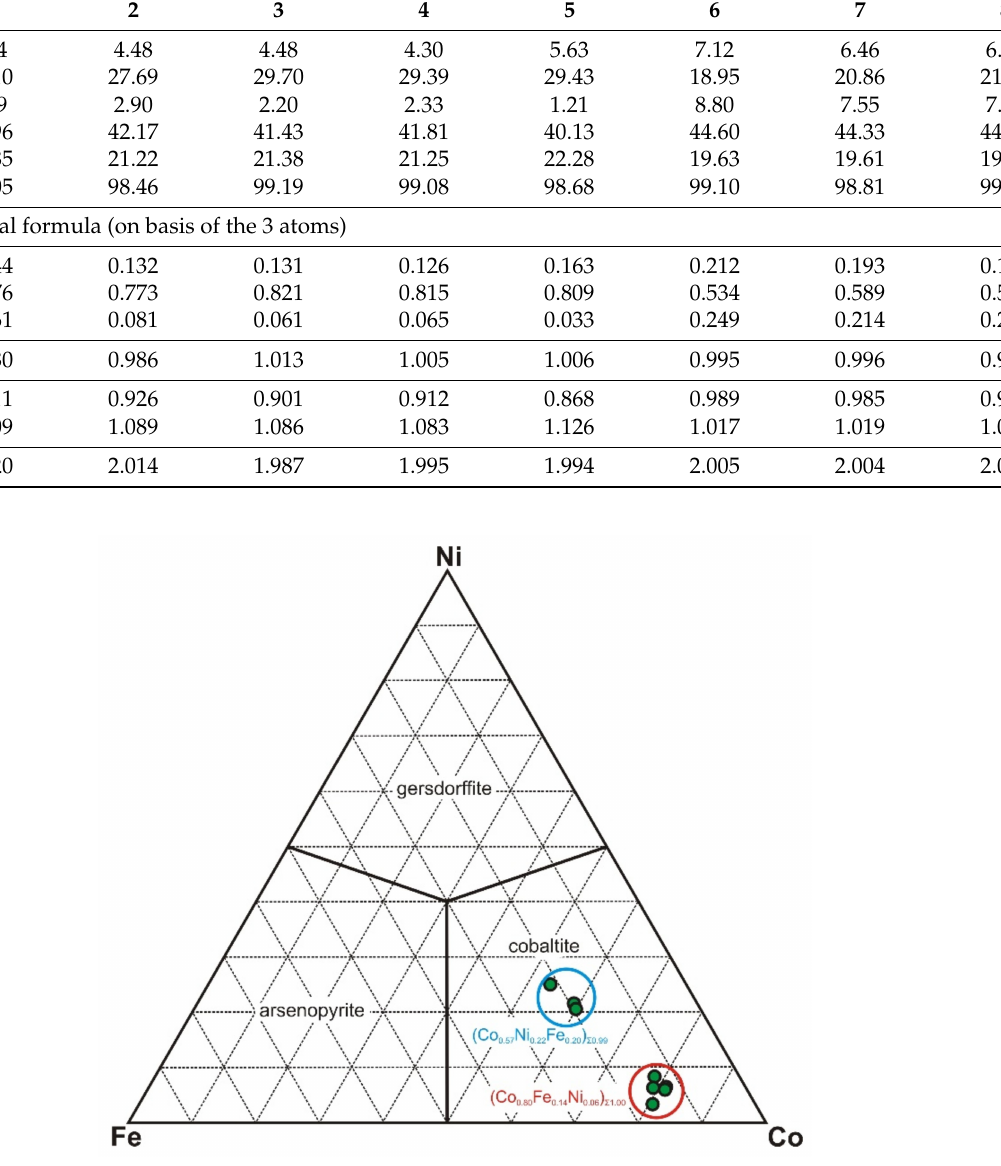
Figure 6. Chemical composition of cobaltite from ˇCuˇcma in ternary system Fe-Co-Ni. Tetradymite was found in only one case. It forms an irregular grain (0.3 mm in size) in close spatial association with molybdenite, uraninite, titanite and chlorite (Figure 7a). The chemical composition of tetradymite is relatively stable (Table 7, Figure 8), containing only minor amounts of Sb (about 0.06 apfu ), Pb (up to 0.01 apfu ) and Se (with a maximum of 0.03 apfu ). The average empirical formula of the tetradymite from ˇCuˇcma based on five atoms is (Bi 2.03 Sb 0.06 Pb 0.01 ) Σ 2.10 Te 1.92 (S 0.96 Se 0.02 ) Σ 0.98